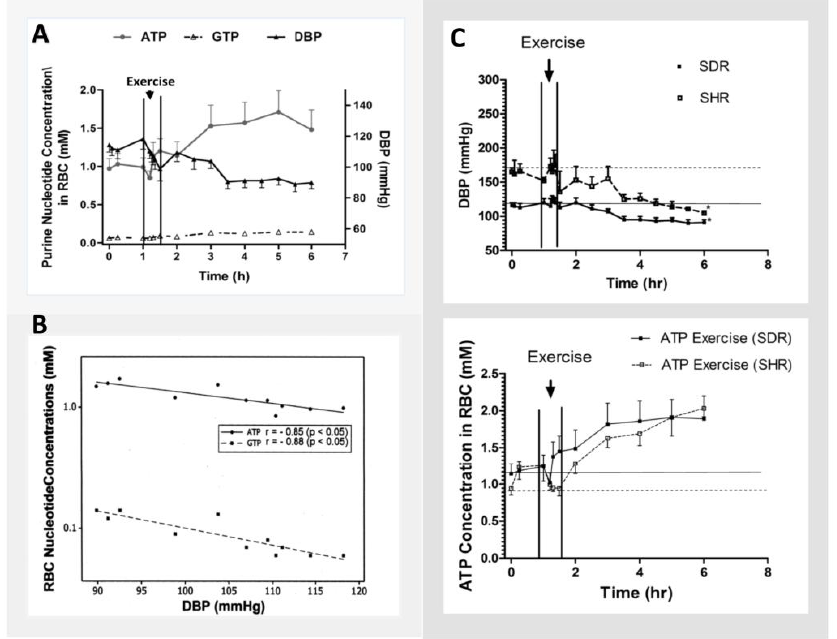
Figure 4. Effect of exercise on hemodynamics and RBC concentrations of purine nucleotides in normotensive Sprague Dawley rats (SDR), and spontaneously hypertensive rats (SHR). Each point represents mean ± SEM for ( A , C ). For ( B ), each point represents mean value of 9 SDR. Abbreviations: ATP = Adenosine 5’-triphosphate; GTP = guanosine 5’-triphosphate.